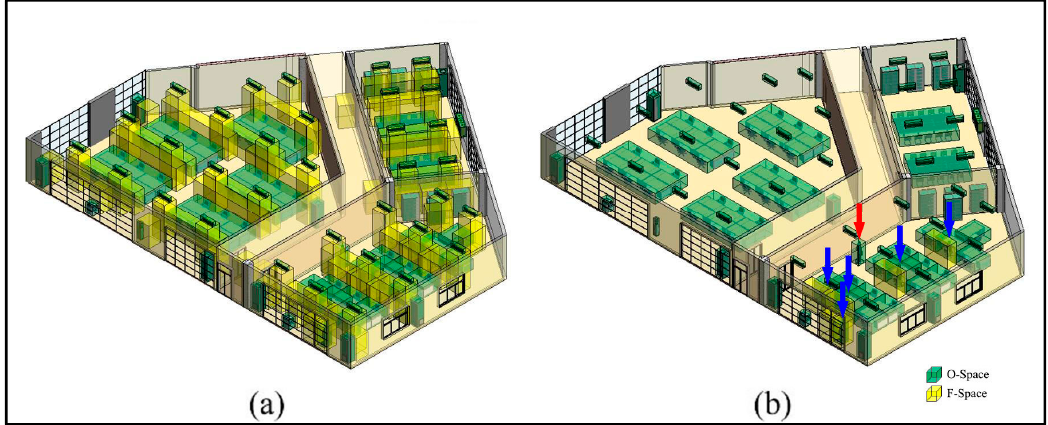
Figure 11. The layout of the experimental environment. ( a ) All F-Spaces of indoor objects. ( b ) Non- navigable F-Spaces of indoor